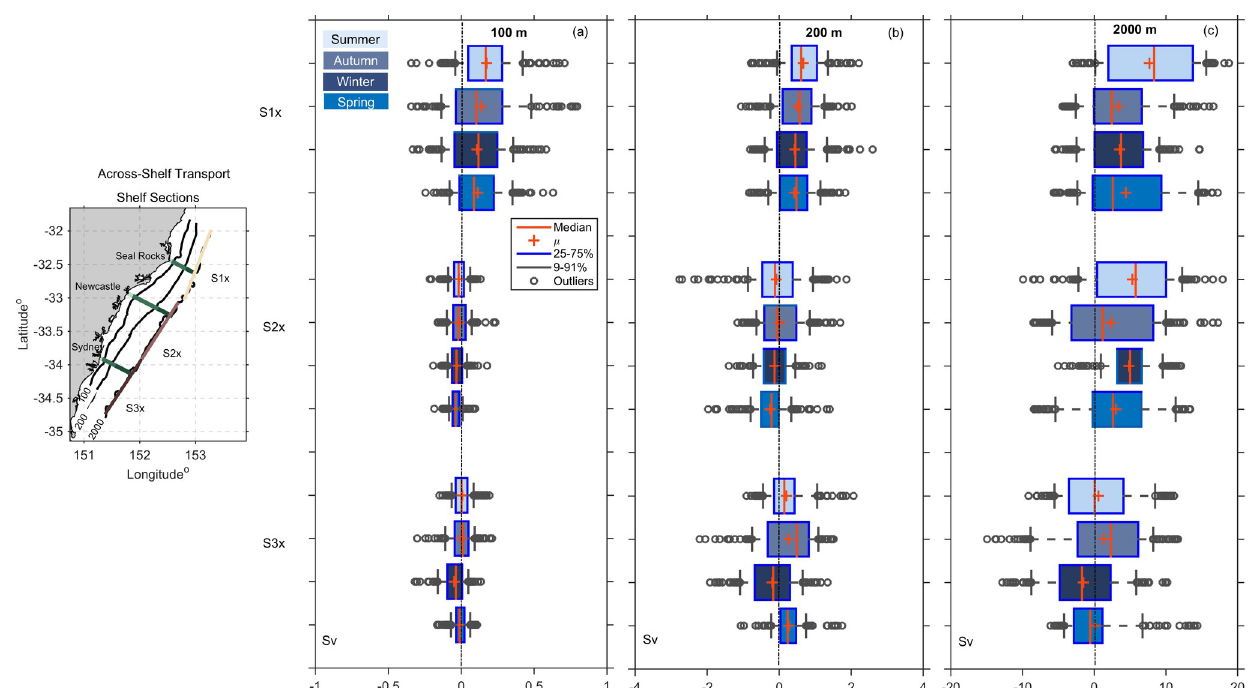
Fig 9. Box plots showing the cross-shelf transport estimates (in Sv) over the shelf, for 3 sections encompassing Seal Rocks (S1x), Newcastle (S2x) and Sydney (S3x) as shown in the map. Transport a) across the 100 m isobath, b) across the 200 m isobath, and c) across the 2000 m isobath for the 3 sections. Note the different scales for a, b, and c. As per the legend, the box plot shows the median, the mean, the box shows the 25th to 75th percentiles, the tails show the 9th and 91st percentile, and the outliers are shown as circles.